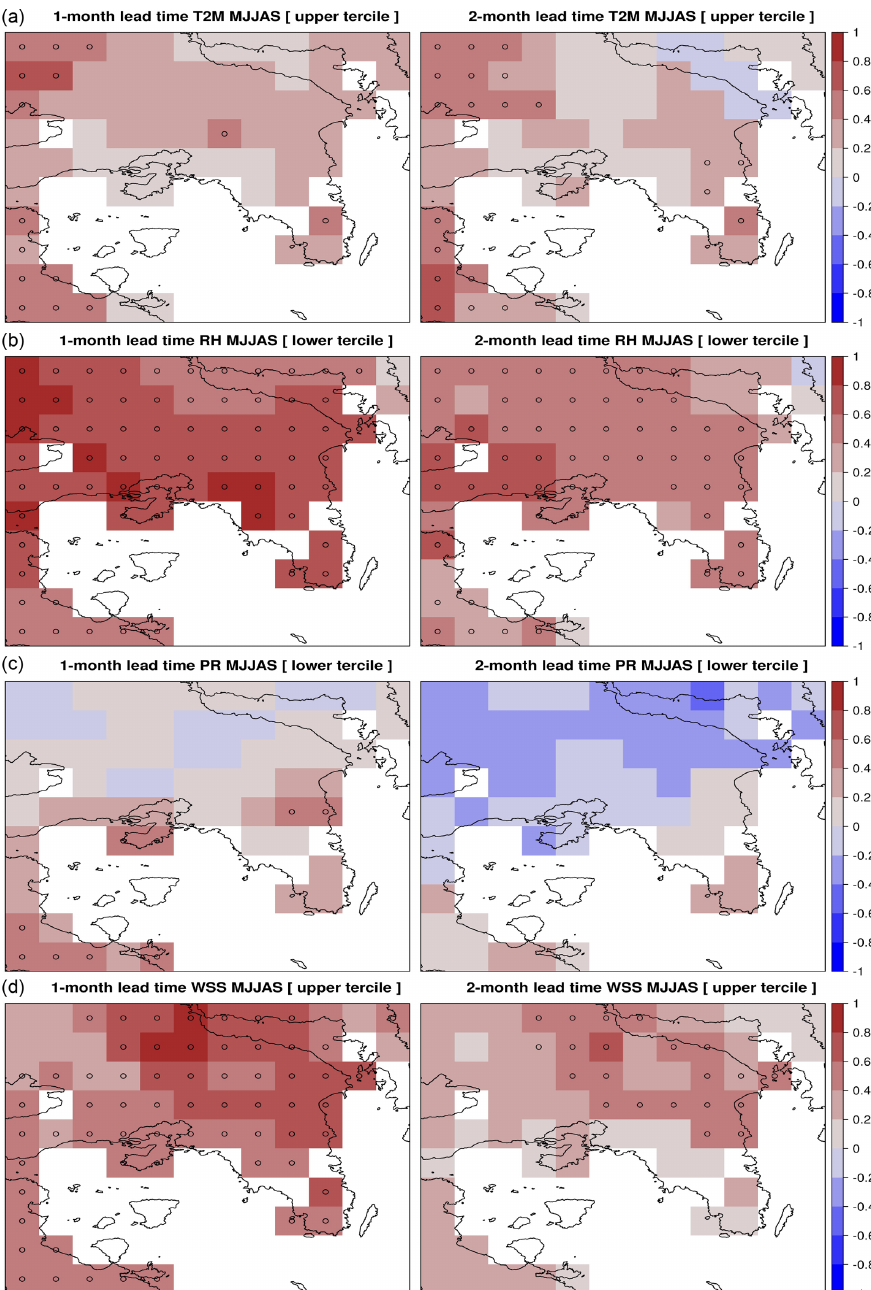
Figure 4. ROCSSs of the FWI input variables for 1-month (left column) and 2-month (right column) lead time forecasts that correspond to high-fire-danger values: (a) upper tercile of air temperature (T2M), (b) lower tercile of air relative humidity (RH), (c) lower tercile of total precipitation (PR) and (d) upper tercile of wind speed (WSS). The grid points with significant ROCSS values are indicated by circles ( α = 0 .